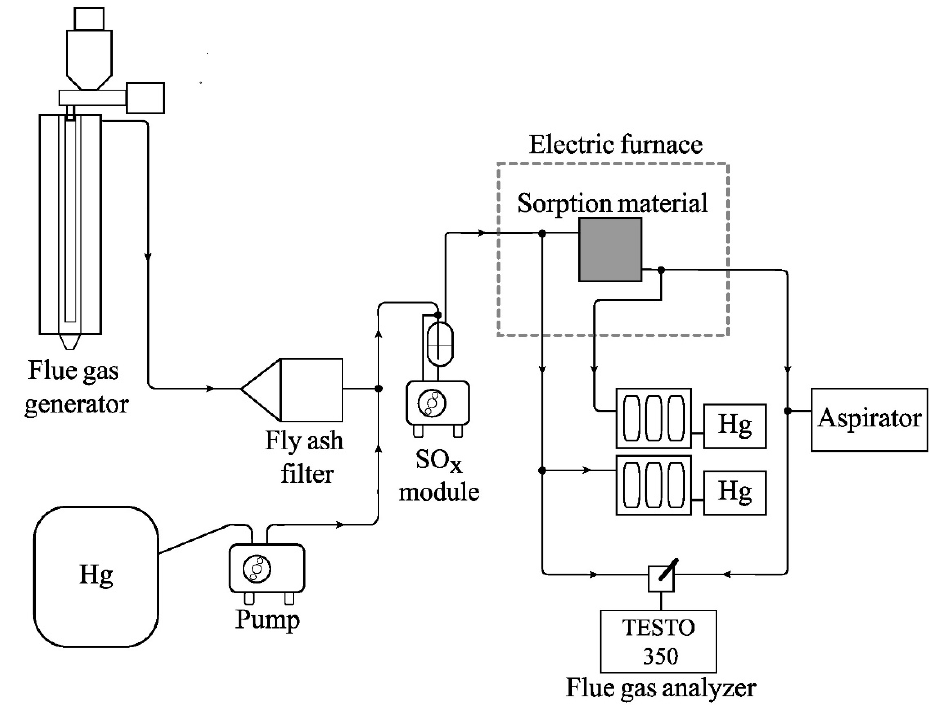
Figure 2. The laboratory system for testing FSM in flue gas.